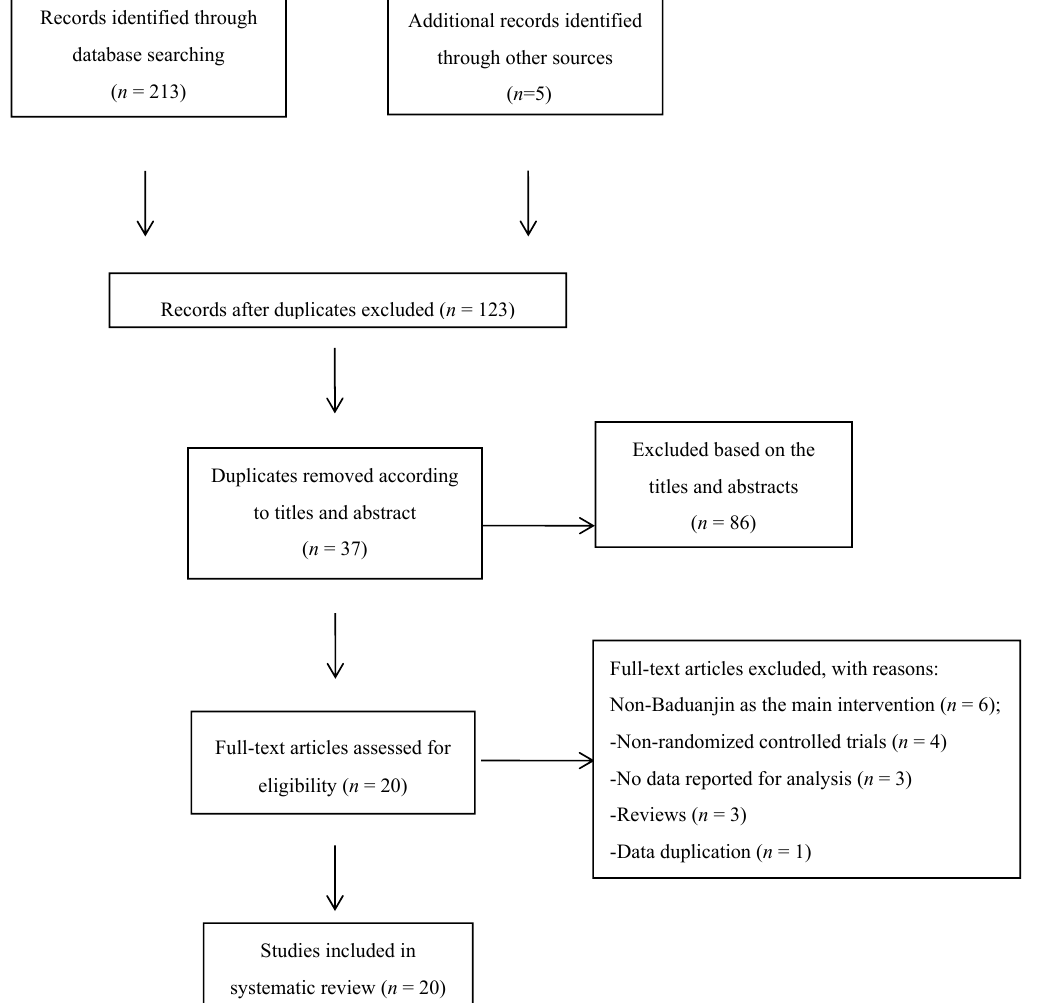
Figure 1. Flow of study selection.